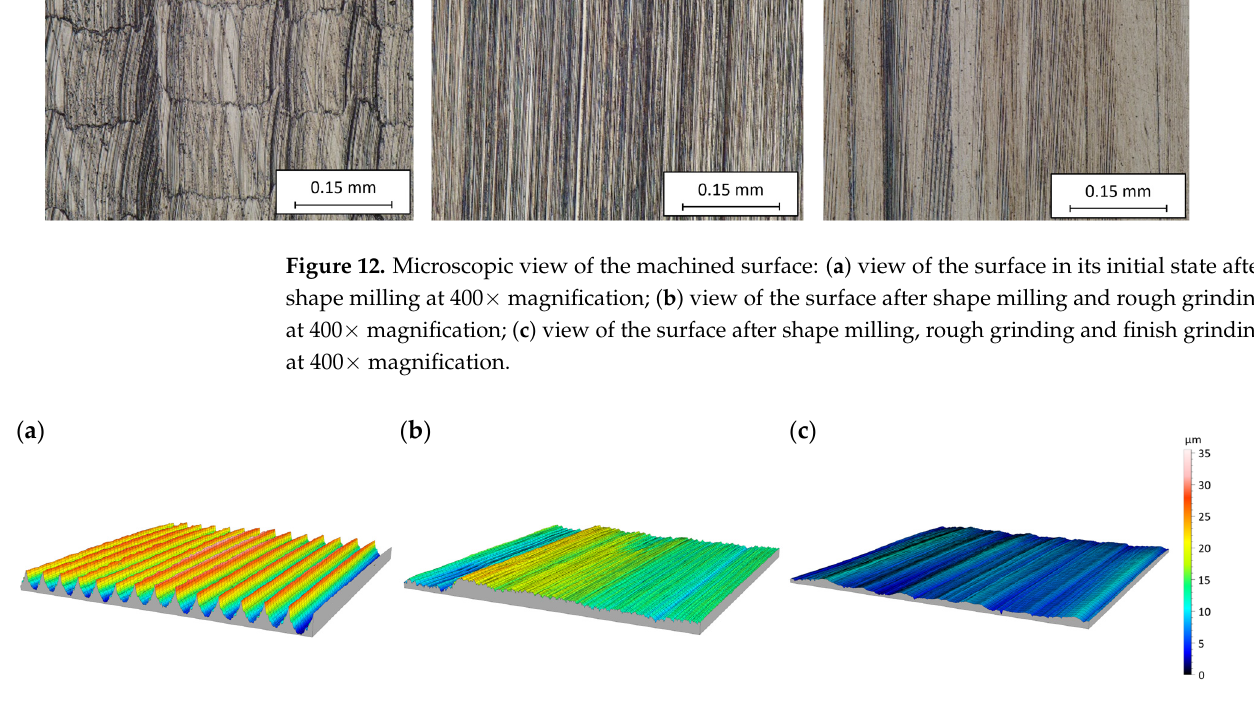
Figure 13. The 3D microtopography view of the machined surface: ( a ) initial surface after contour milling; ( b ) surface after contour milling and coarse grinding; ( c ) post-surface after contour milling, coarse grinding and finish grinding.